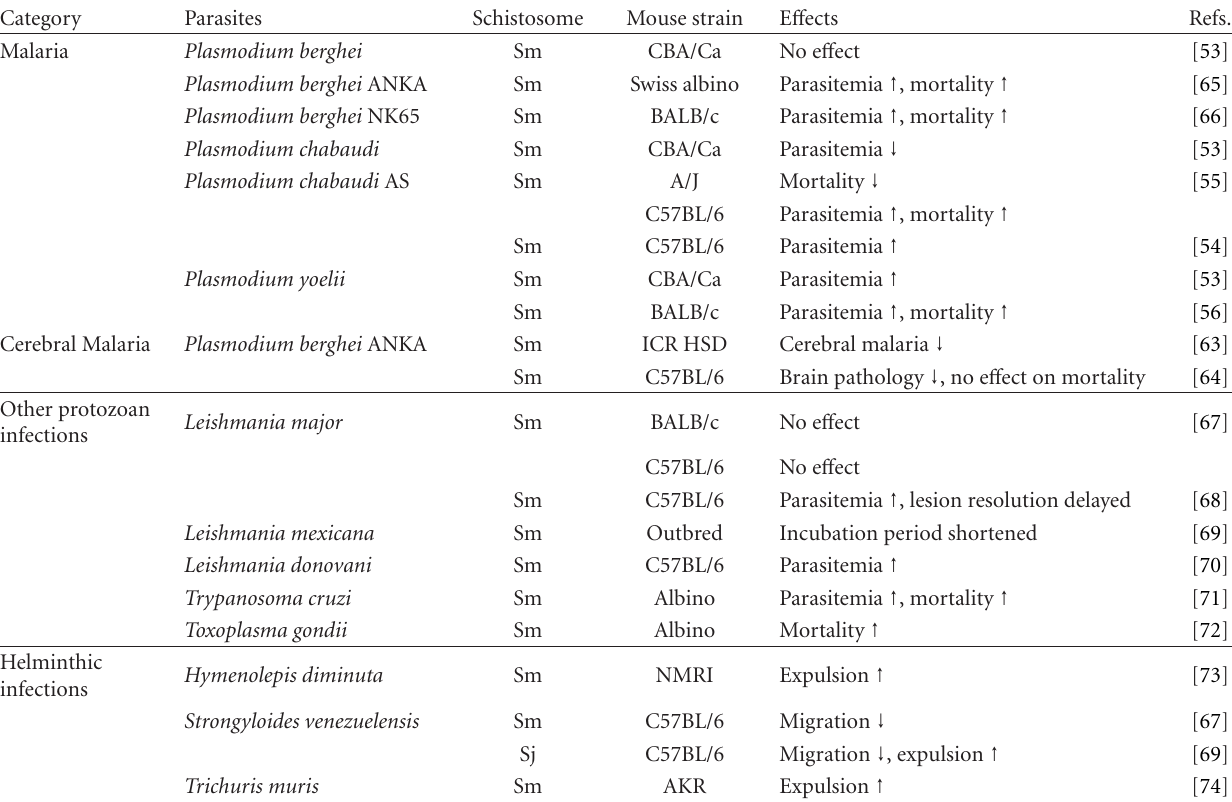
Table 2: E ff ects of schistosome on other parasitic infections in